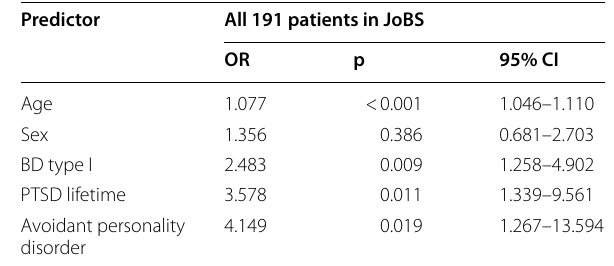
Table 2 Multivariate logistic regression model of predictors of Table 3 Multivariate logistic regression model of predictors disability pension during 6-year follow-up in Jorvi Bipolar Study of disability pension during 6-year follow-up for 191 patients in Jorvi Bipolar Study, including patients granted a disability Predictor Patients not on pension at baseline pension before (N